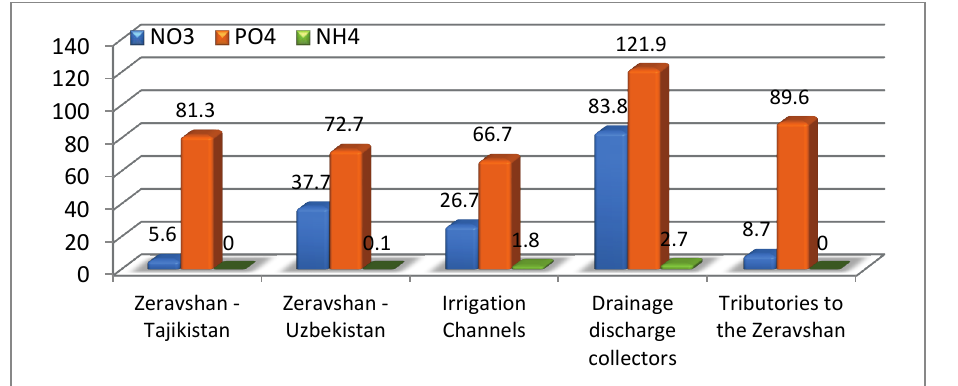
Fig. 1 Content of nitrate, phosphate and ammonium of Zeravshan River in Tajikistan and Uzbekistan territories, irrigation channels, drainage collectors in Uzbekistan and tributaries of Zeravshan